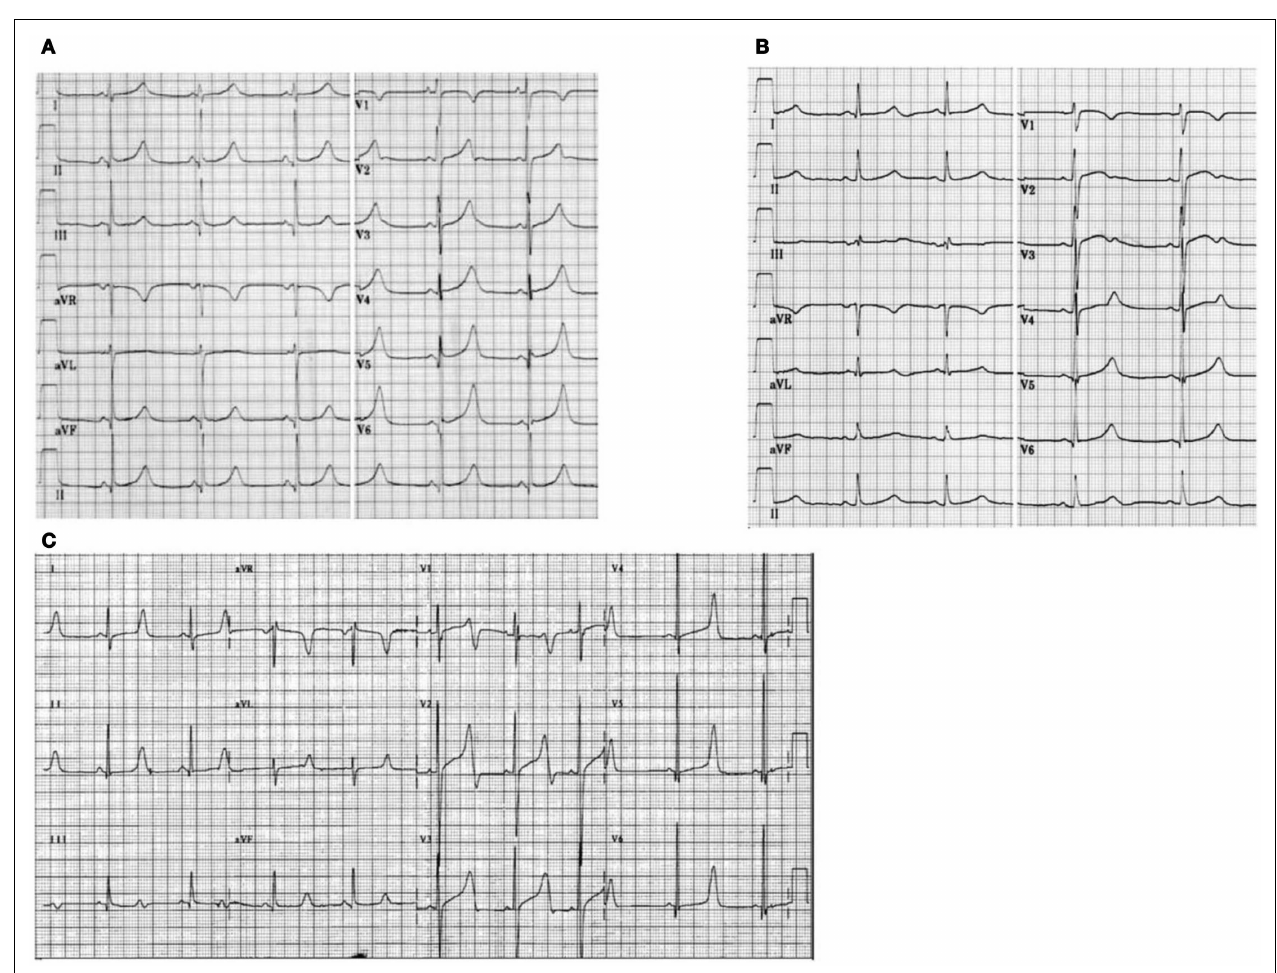
notched in leadV3 and has relatively low amplitude in the extremity leads. Conduction interval is normal (standard calibration). (C) 12-lead ECG of a 12-year-old boy with a SCN5A mutation.The QT interval is prolonged (QTc ± 600ms).The ST segment has a long (almost) iso-electric segment with a large, sharp, and narrow T wave. Conduction interval is normal (standard